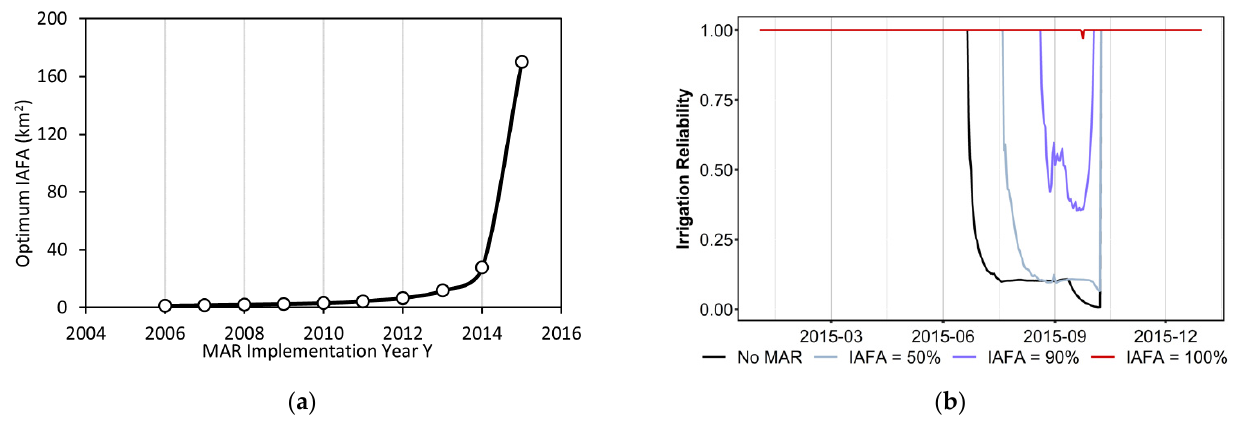
Figure 11. ( a ) Optimum IAFA for different MAR implementation year (infiltration rate and vertical hydraulic conductivity were fixed). ( b ) Change in irrigation reliability for MAR implementation time in 2010 and sensitivity based on IAFA at 50%, 90%, and 100% of the optimum IAFA for 2010.